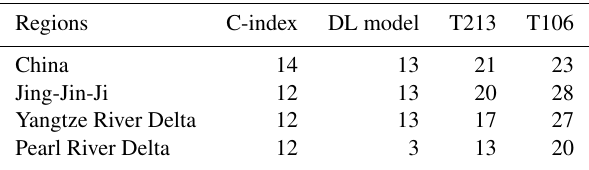
Table 3. Timing (in days) of the minimum in the migration data and NO x emissions during 30d after the 2020 CNY.